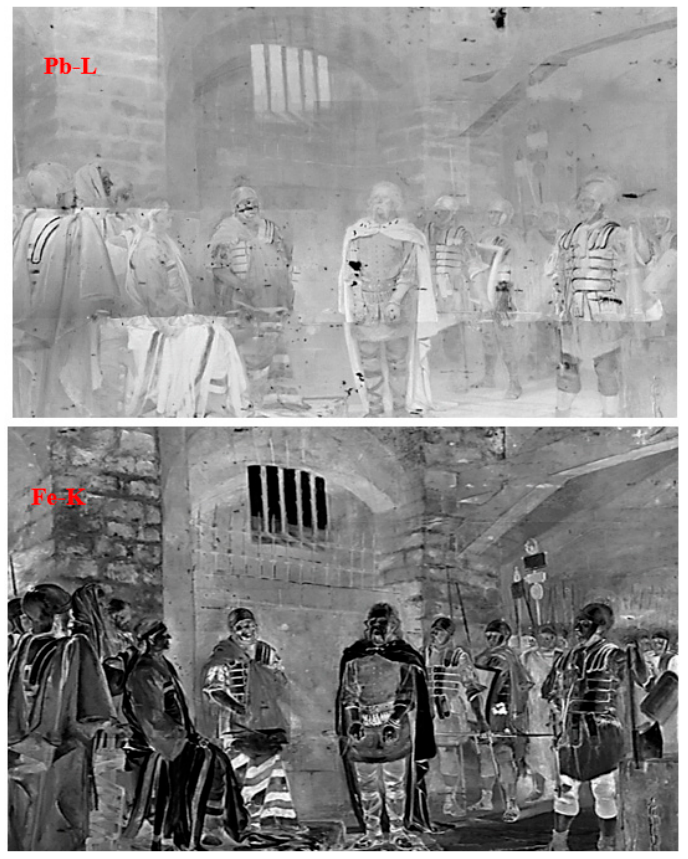
Figure 5. Pb-L and Fe-K elemental maps of painting “ Vercingetorix diante de Júlio de Cesar ” by Firmino Monteiro.